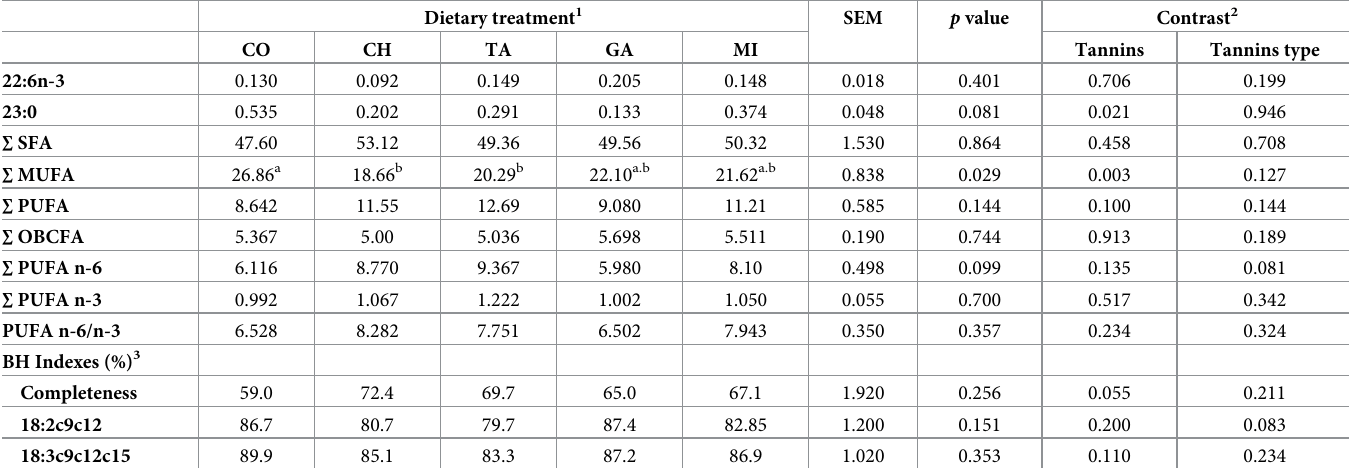
HT showed a greater proportion than CT. The multiple comparisons between dietary treat- ment groups showed that the sum of odd- and branched-chain fatty acids (OBCFA) was not affected by the diet. However, an effect of tannin supplementation was observed on individual OBCFA, with 13:0 ( P = 0.051) and 13:0 iso ( P = 0.022) greater in the in tannins-fed lambs in comparison with CO, whereas an opposite result was found for 17:0 anteiso ( P = 0.013). Regarding tannin type, the proportion of 17:0 and 17:0 iso was greater in the rumen content of lambs fed CT ( P = 0.024 and P = 0.033, respectively). Dietary treatment ( P = 0.029) and tan- nins supplementation ( P = 0.003) affected total monounsaturated fatty acids (MUFA). These results were mainly related to the greater proportion of 18:1 t 6+ t 7+ t 8 and 18:1 t 10 found in the rumen content of CO lambs in comparison to the other groups. Among the groups receiving tannins, only GA showed levels of 18:1 t 6+ t 7+ t 8 comparable to CO. As for the individual PUFA, TA lambs showed a double proportion of 18:2 t 9 c 12 in comparison with all the other groups, which caused that HT fed lambs had a greater proportion of this fatty acid in compari- son to CT ( P = 0.020). Similarly, 18:2 c 9 c 12 tended to be greater in HT lambs than CT ( P = 0.075). Table 4 reports data on the FA composition of liver fat. Dietary treatment affected ( P � 0.05) several trans 18:1 isomers in liver fat. Specifically, 18:1 t 9 and 18:1 t 10 were greater in MI than CH liver. Moreover, 18:1 t 10 was found at greater percentage in the liver fat of CO in comparison with CH, TA and GA. Also, 18:1 t 10 was greater in MI than CH, whereas the per- centage of 18:1 t 11 was greater in CO than GA liver. Overall, tannins supplementation reduced ( P � 0.05) the percentage of 18:1 t 9, 18:1 t 10 and 18:1 t 11 in comparison with CO. Between the different classes of tannins, 18:1 t 10 was found at lower percentage ( P = 0.037) in the liver fat of HT- lambs than CT-supplemented lambs. Regarding PUFA in liver fat, dietary treatment affected 20:5n-3, which was greater ( P = 0.042) for CO than MI. Tannin supplementation over- all reduced ( P � 0.05) 18:2 c 9 t 11 and 18:2 t 9 c 12 as compared to